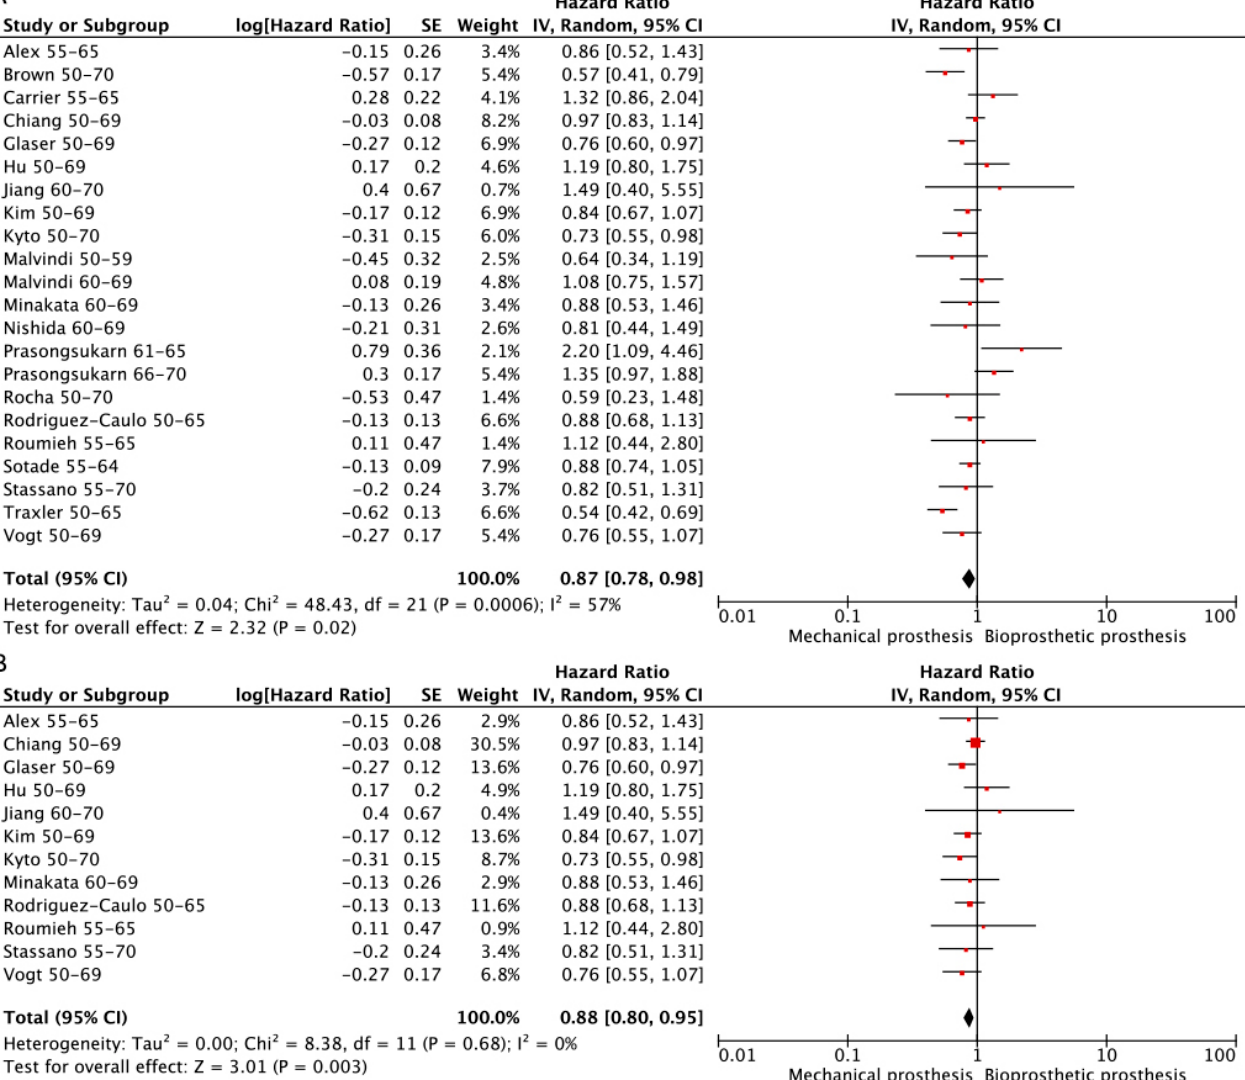
Figure 3. Meta ‐ analysis for long ‐ term survival. ( A ) Bioprosthetic vs. mechanical. ( B ) Bioprosthetic vs. mechanical (RCT or PSM).